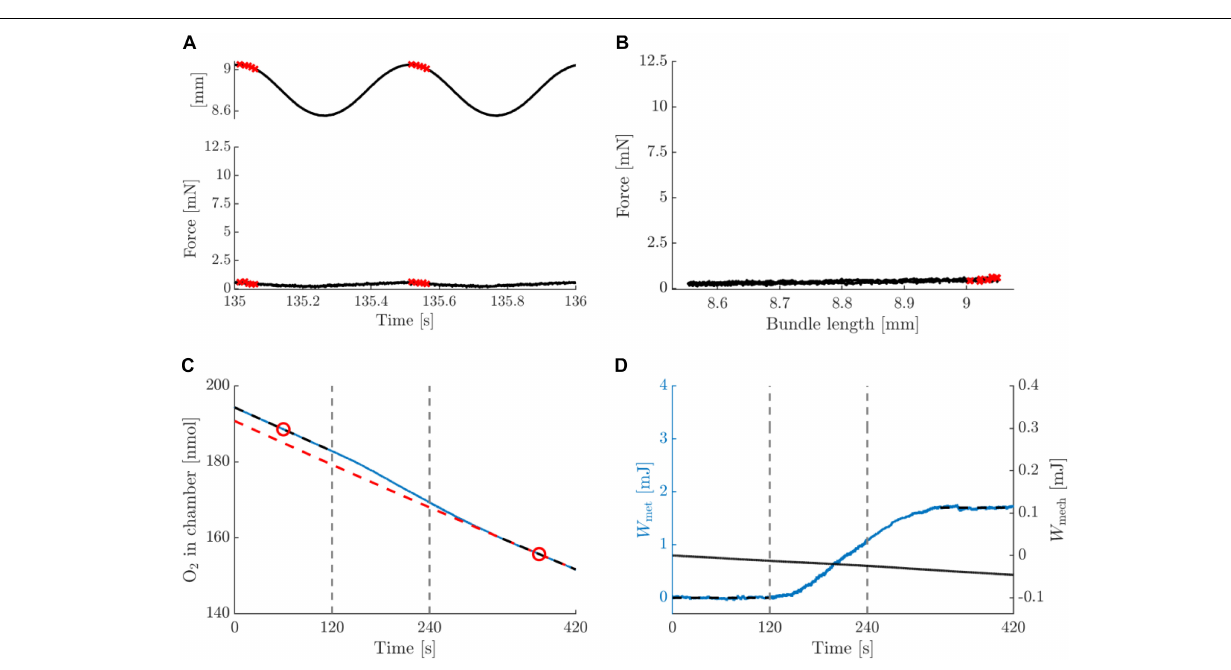
FIGURE 6 | Summary data for a typical example of an eccentric contraction with amplitude 0.25 mm and movement frequency 2 Hz, post-blebbistatin. Figure lay-out identical to that of Figure 3 ; see legend